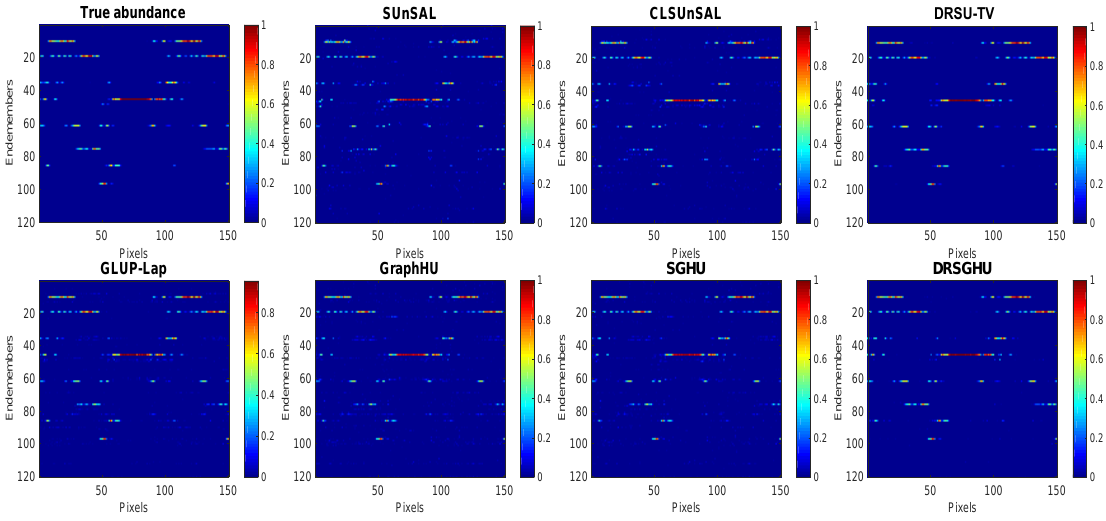
Figure 3. Top panel, from left to right: Ground-truth fractional abundances in DC1 containing 150 pixels and k = 9 endmembers randomly extracted from library A 1 , and fractional abundances estimated by SUnSAL, CLSUnSAL, and DRSU-TV. Bottom panel: Fractional abundances estimated by GLUP-Lap, GraphHU, SGHU and DRSGHU.